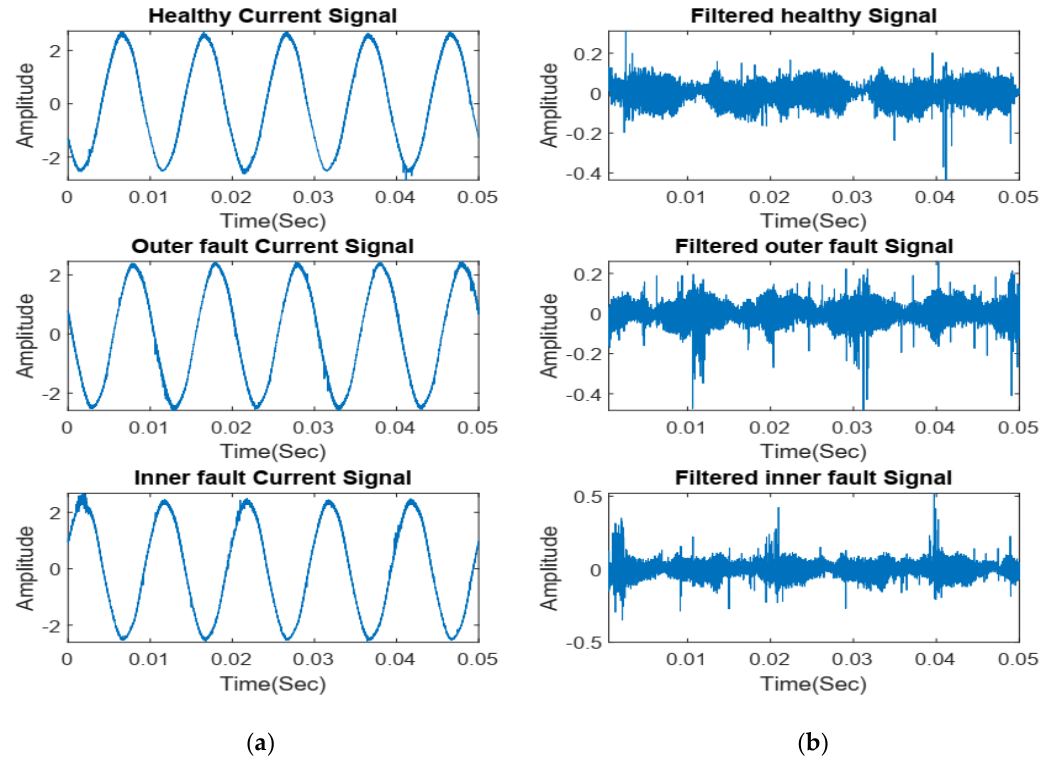
Figure 7. ( a ) Raw and ( b ) filtered signals of three types of bearing states.